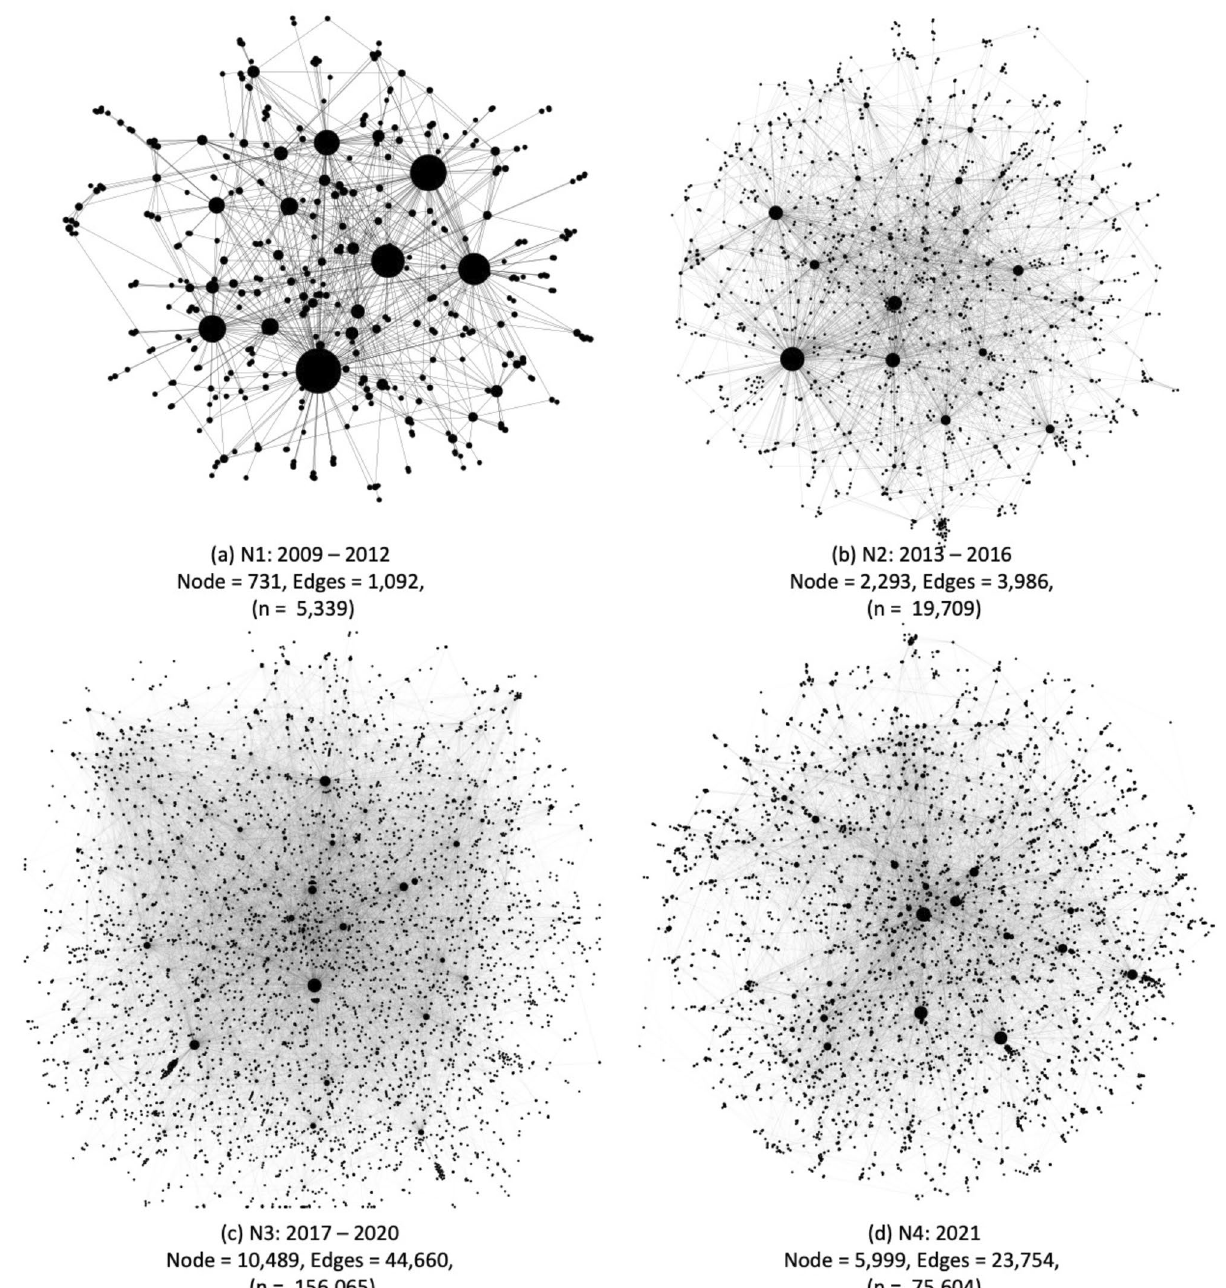
Figure 3. Topologies of hashtag co-occurrence networks (N1–N4) across the 13-year timeline (2009–2021) denoting diffusion of climate policy events into the public domain. The size of the node is respective to its frequency in a particular